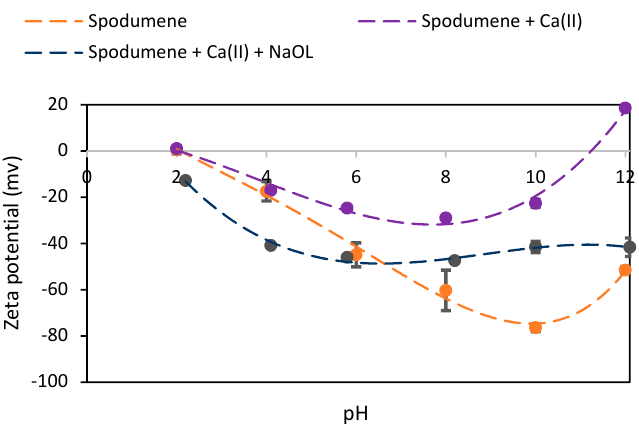
Figure 6. Comparison of the zeta potential of the spodumene surface with or without NaOl and CaCl 2 (250 and 120 mg/L, respectively).